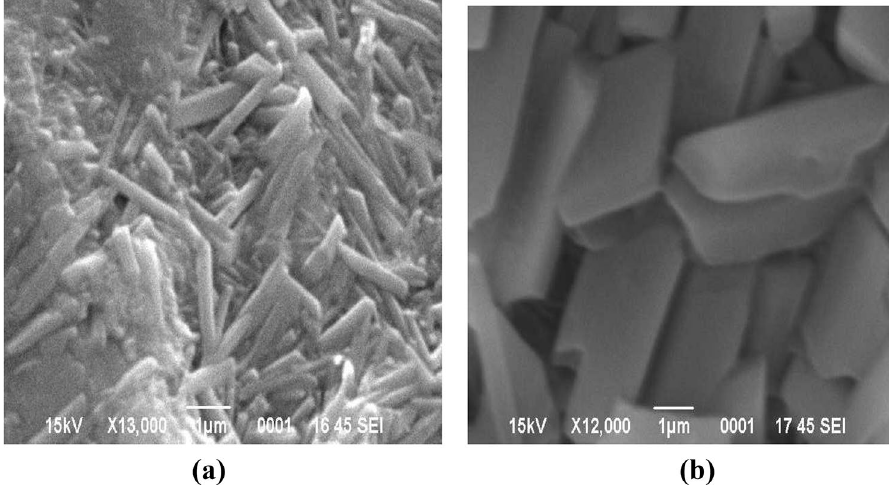
Fig. 3 SEM images of a CaO-M and b